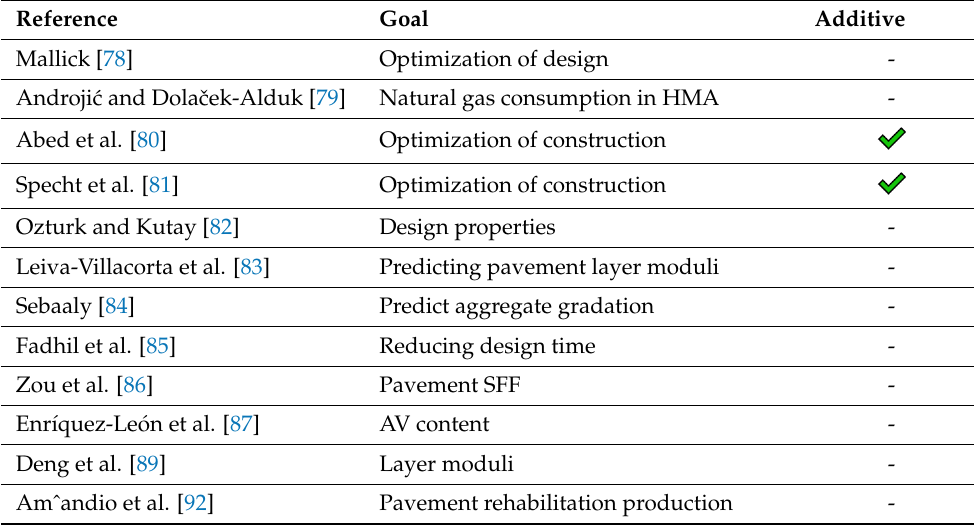
Table 2. Comparison of methods used in prediction of flexible pavement performance.